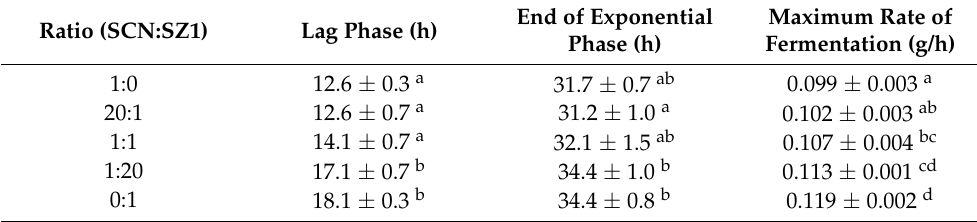
Figure 1. Fermentation progress over 80 h of S. cerevisiae (SCN) and S. pombe (SZ1) monocultures, and three mixed cultures at 20:1, 1:1, and 1:20 initial inoculation ratio in standard-gravity wort (1.049), modelled with the modified 4-parameter logistic curve. All readings from independent biological replicates ( n = 3) are shown, with the model fit to the full set of data points. Table 1. Fermentation kinetics of S. cerevisiae (SCN) and S. pombe (SZ1) monocultures, and three mixed cultures at 20:1, 1:1, and 1:20 initial inoculation ratio in standard-gravity wort (SG